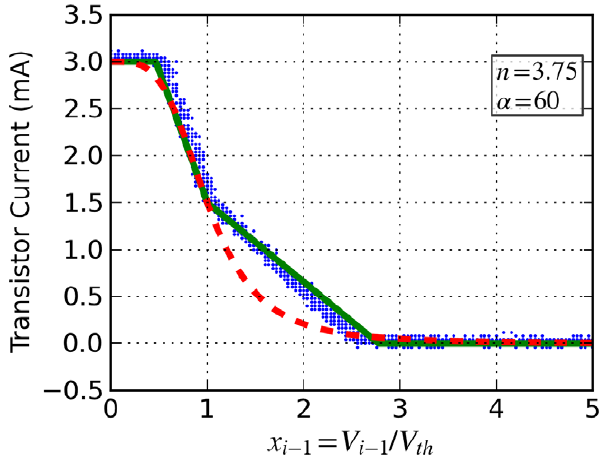
Figure 2. Hill function inhibitory response. Hill function inhibition of gene expression is approximated by the transistor current’s dependence on input voltage V i-1 for the circuit in Fig. 1. Hill function (red dashed line), predicted current (green solid line), and measured current (blue dots). Maximum transistor current of 3 mA corresponds to maximum transcription rate a =60. The Hill coefficient is n =3.75.